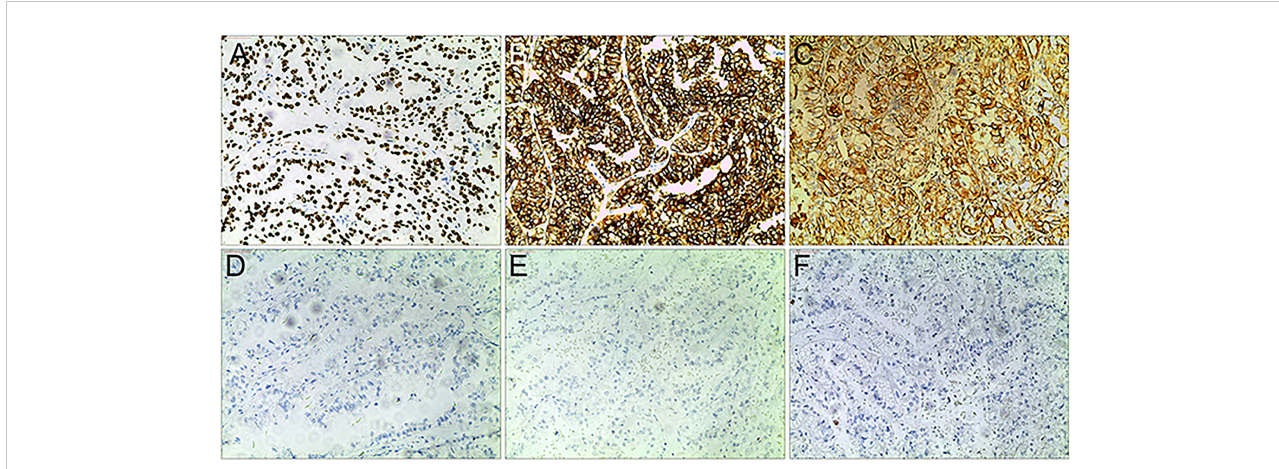
FIGURE 2 Representative IHC images of Xp11.2 tRCCs. (A – C) positive results of TFE3, CD10 and Vimentin. (D – F) Negative results of cathepsin K, CD117 and CA-IX. Original magni fi cation: × 100 (A – F) .